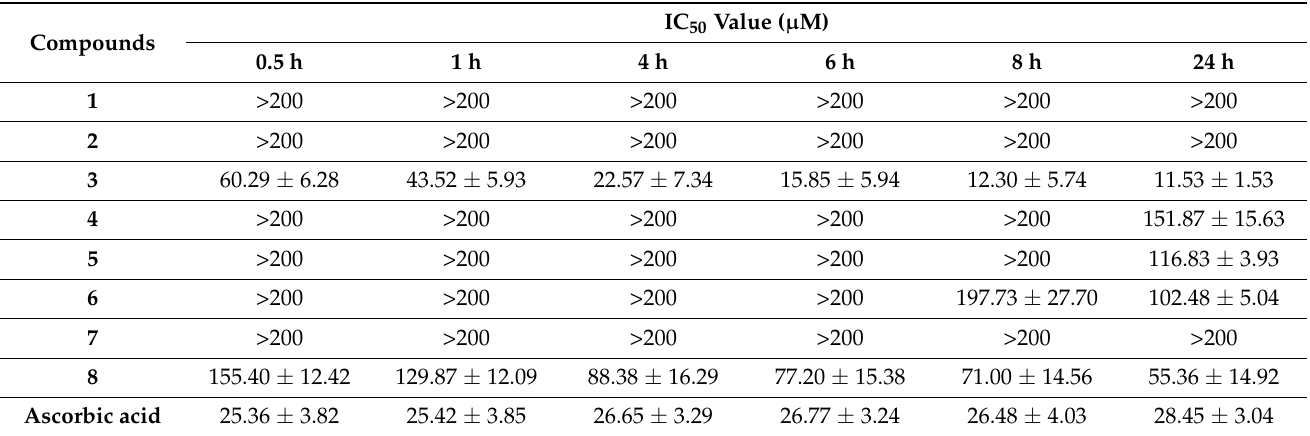
Figure 5. DPPH radical scavenging activity of compound 3 and ascorbic acid as the positive control at 0.5, 1, 4, 6, 8 and 24 h. Table 4. DPPH radical scavenging activities of compounds 1 – 8 .